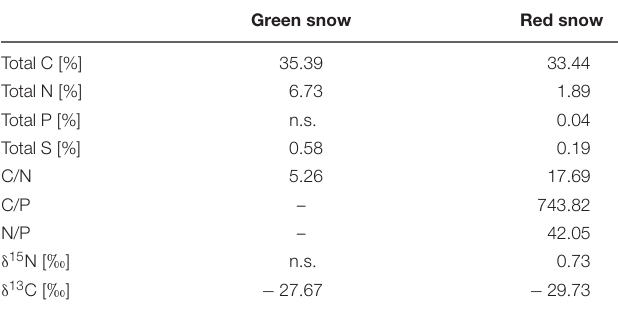
TABLE 2 | Organic (DOC) and inorganic aqueous chemical data for green TABLE 3 | Total carbon (TC), total nitrogen (TN), total phosphorus (TP), and and red snow. total sulfur (TS) (all based on % of dry weight of sample), nitrogen and carbon isotope values, and particulate C/N, C/P, and N/P ratios calculated Green now Red snow from TC, TN, and TP